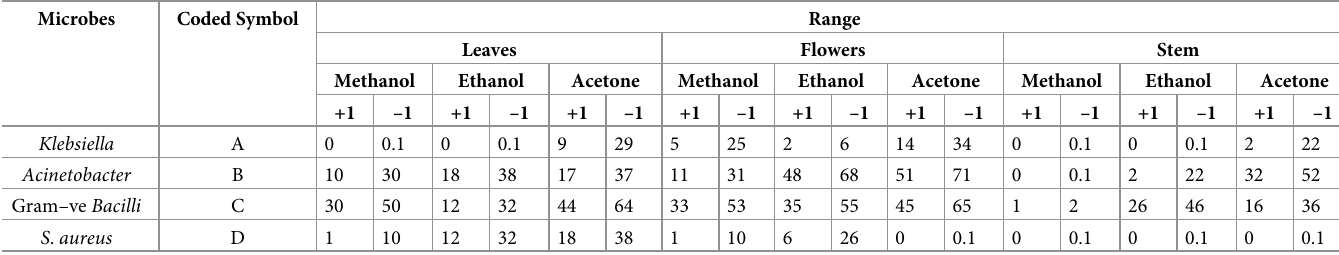
Table 1. A design approach for determining the optimization of anti-microbial activity of A . absenthia via Box-Behnken